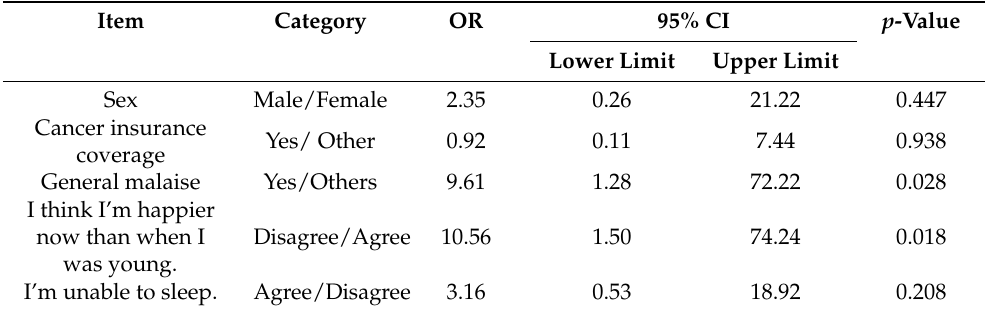
Table 5. The impact of general malaise, “I think I’m happier now than when I was young”, and “I’m unable to sleep” on current life